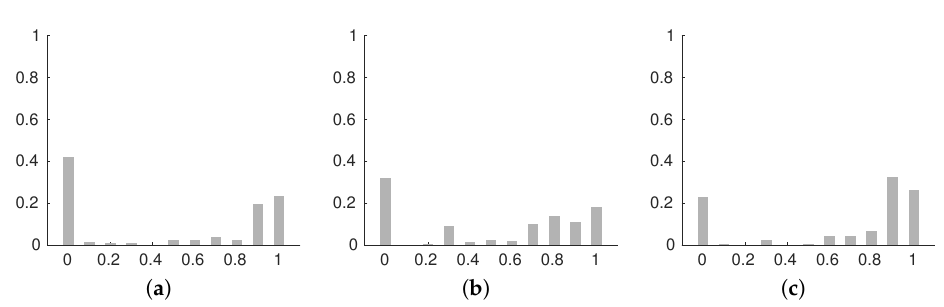
Figure 3. Histogram of the percentage of samples from each 10% interval of the image analyses for training, validation and testing dataset of the Gulf of Saint Lawrence. The training samples are strongly biased since the majority of the training samples are either water or ice. ( a ) Training; ( b ) Validation; ( c ) Testing.